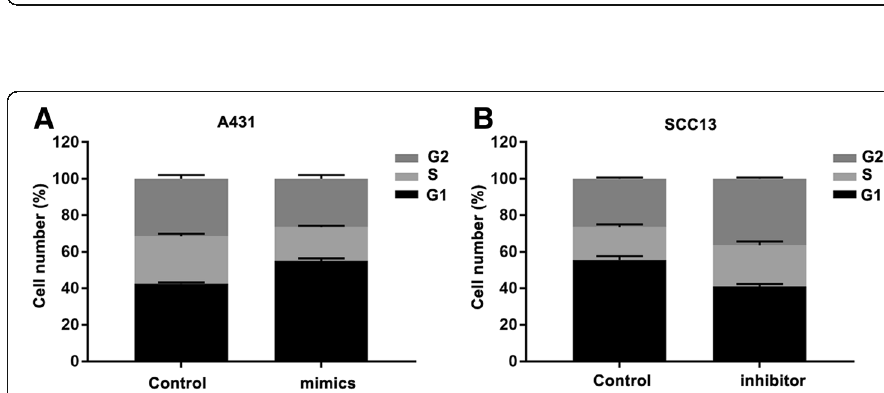
Fig. 3 miR-221 regulates cell cycle in CSCC. Quantitative results of cell-cycle assay in A431 ( a ) and SCC13 ( b ) cells transfected with miR-221 inhibitor or mimic, respectively. * P < 0.05, compared with